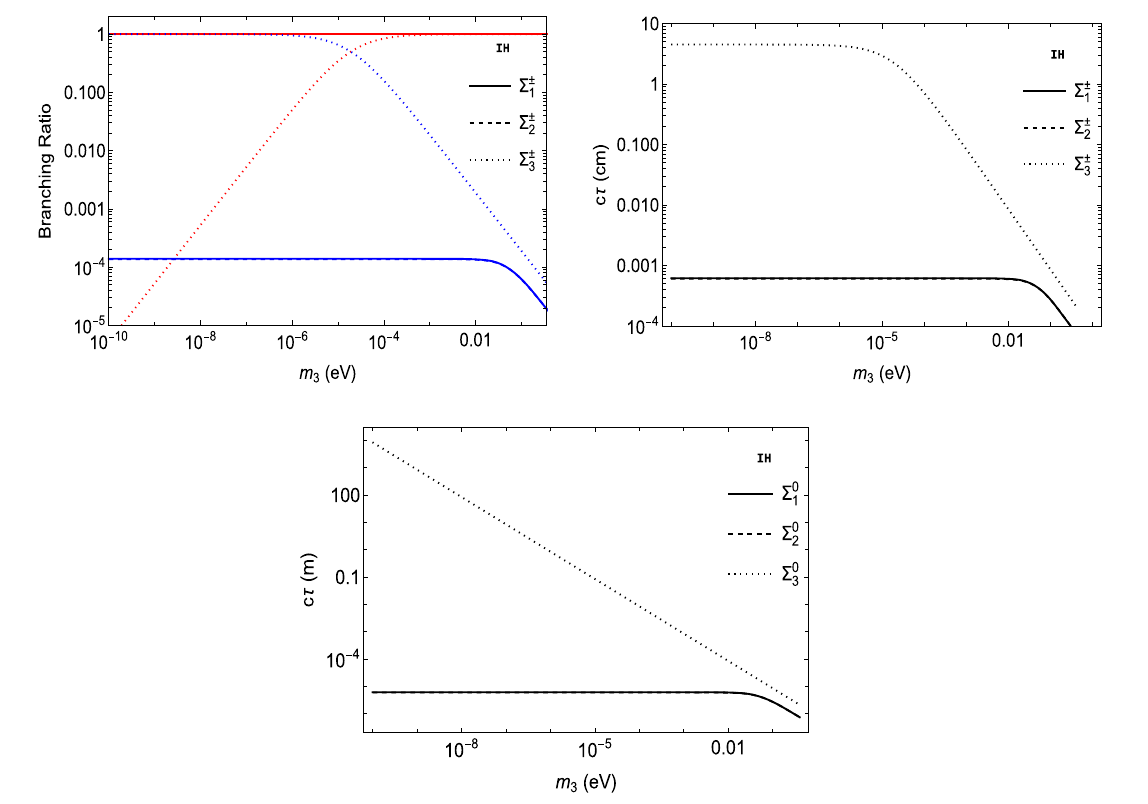
= 600 GeV and m (cid:2) = 1 TeV, panels, respectively, and decay length of (cid:2) 0 3 1 , 2 observed neutrino mass m 1 in the bottom panel. The blue (red) lines as a func- i depict branching ratio for (cid:2) ±